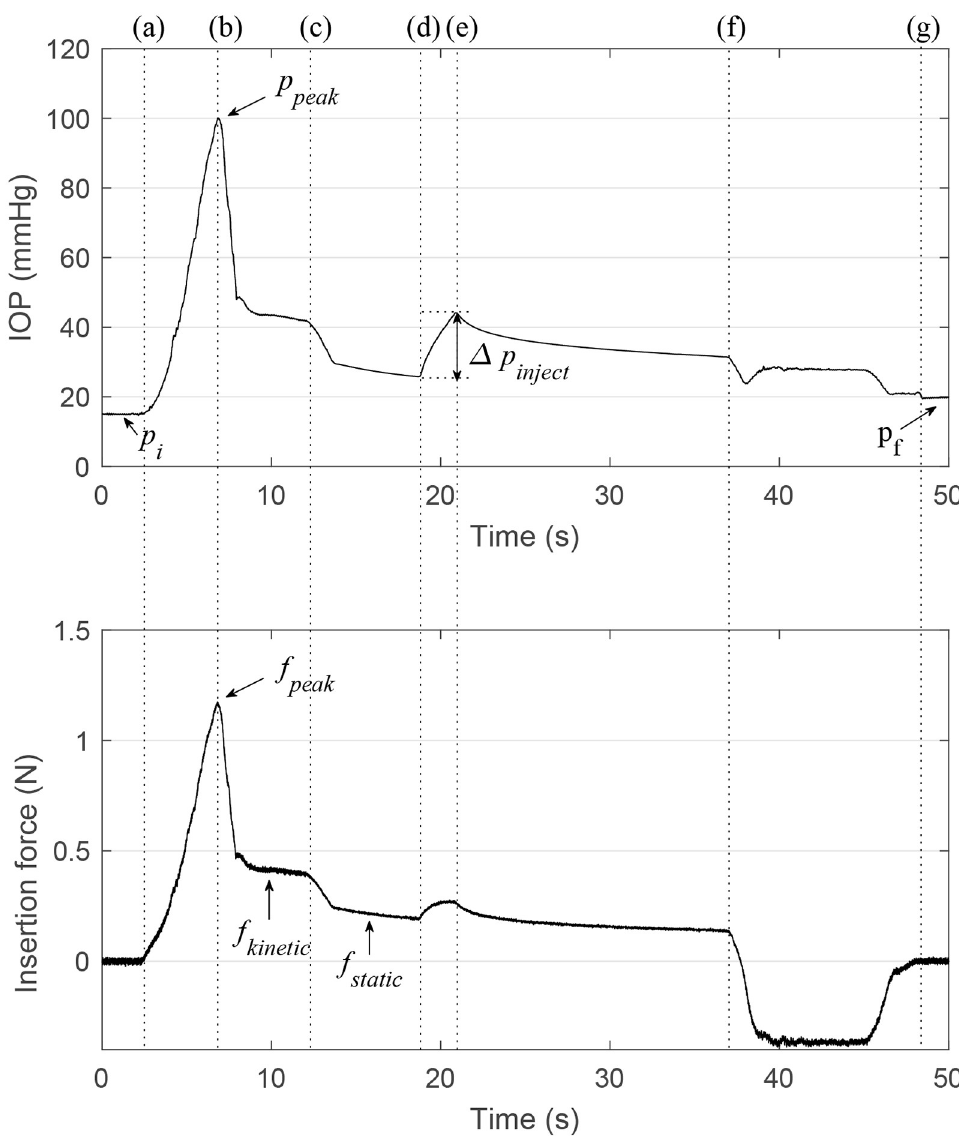
Fig 2. Typical intraocular pressure and insertion force profiles during intravitreal injection. The needle contacts the eye (a), penetrates the sclera (b), and stops (c). The injection is initiated (d) and ended (e). The needle extraction is initiated (f) and ended